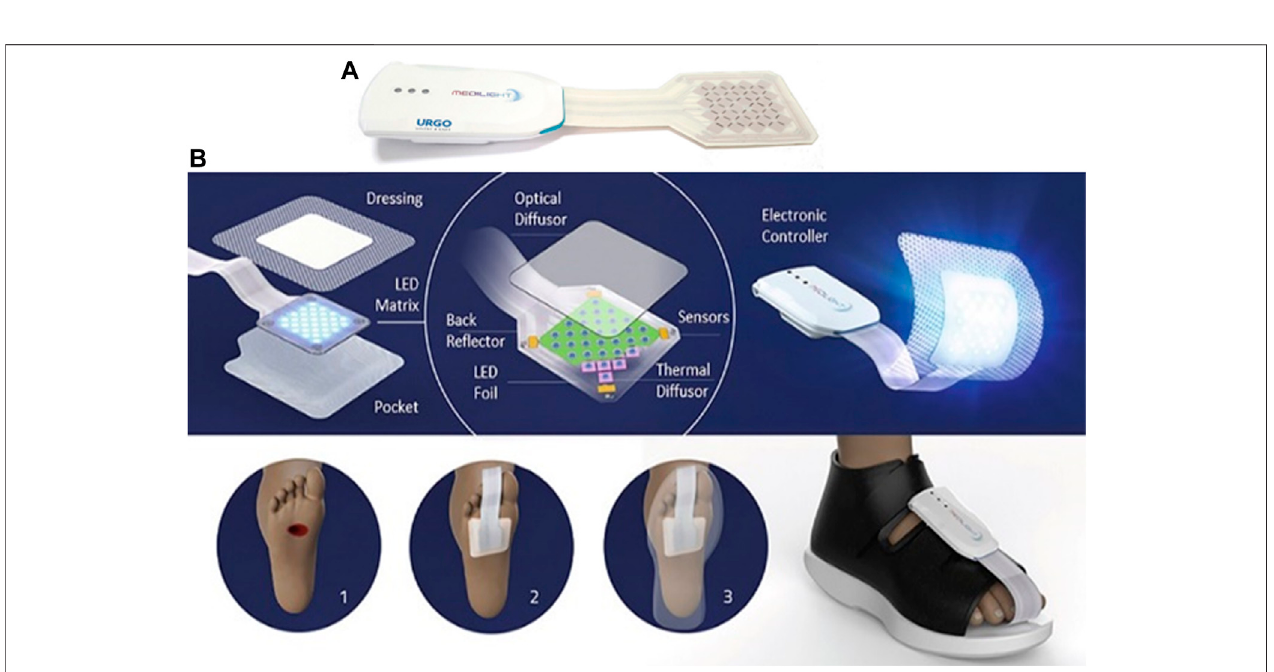
FIGURE 6 | (A) Developed smart foot patch used in the treatment of chronic wounds, with the permission from MEDILIGHT © Group AMIRES-EU Projects, (B1) Illustration of the components and application of the MEDILIGHT © foot patch used in wound healing therapy. Depiction of bare chronic wound, (B2) depiction of the MEDILIGHT © foot patch being applied on a patient ’ s foot, and (B3) MEDILIGHT © foot patch appearance when the shoes are fi tted on.